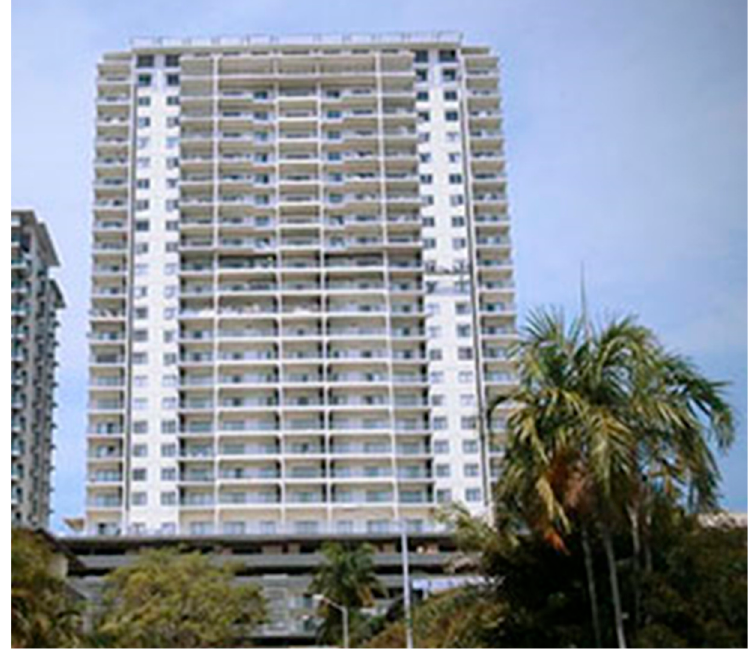
Figure 2. SOHO Apartments in Darwin, Australia [12].